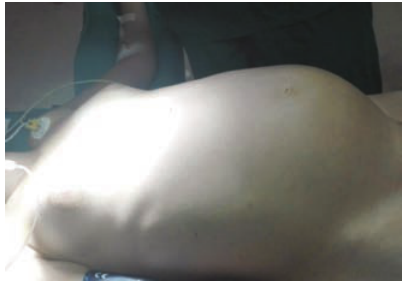
Figure 1. Clinical appearance of a patient with a giant ovarian